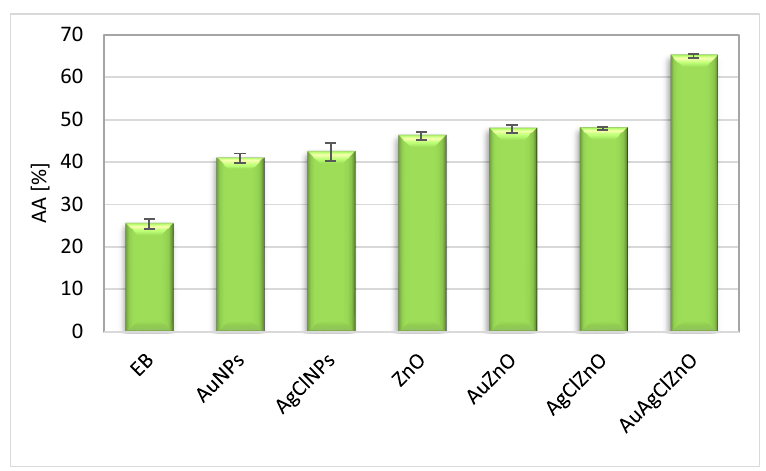
Figure 10. The scavenger activity of ABTS •+ by phytometallic particles.